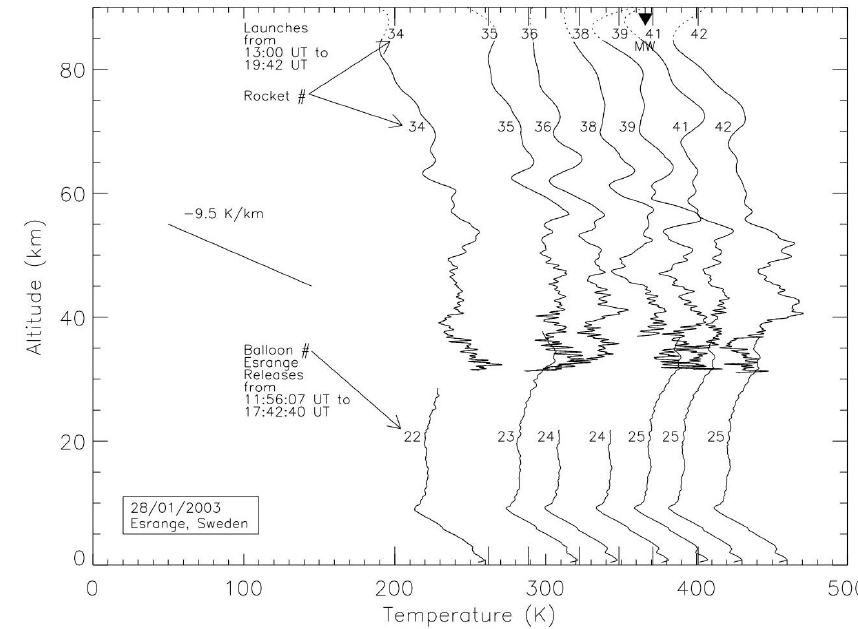
Fig. 14. Waterfall plot similar to Fig. 7, but for the 28 January 2003 sequence at Esrange.